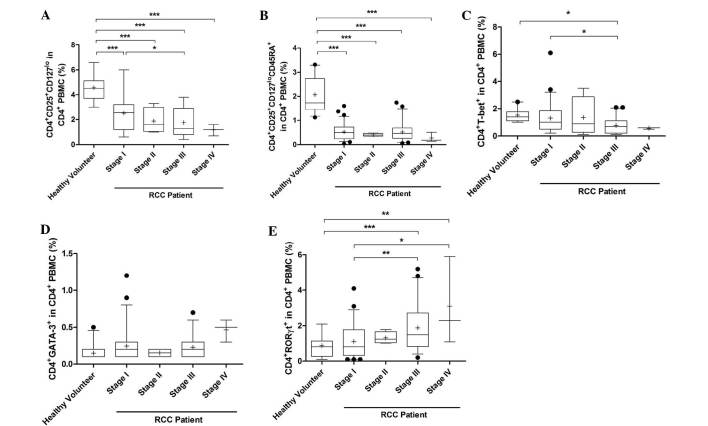
Proportion of Th1/Th2/Th17/Treg cells in different stages of RCC. (A) The percentage of activated Treg (CD4+ CD25+ CD127lo) cells was significantly decreased in stages I-IV (tumor-node-metastasis staging) of RCC patients compared with the healthy volunteers. (B) Percentage of activated Treg cells in stage III was decreased compared with that in stage I. The percentage of naïve Treg (CD4+ CD25+ CD127lo CD45A+) cells in stages I-IV of RCC patients was also decreased. (C) Percentage of Th1 (CD4+ T-bet+) cells in stage III was decreased significantly compared with in stage I and in the healthy volunteers. (D) Percentage of Th2 (CD4+ GATA-3+) cells was partially increased in stages I-IV compared with the healthy volunteers, although not significantly. (E) Percentages of Th17 (CD4+ RORγt+) cells in stages III and IV were markedly increased compared with that in the healthy volunteers. In addition, the proportion of Th17 cells in stages III and IV were higher compared with that in stage I. Data are expressed as the mean ±standard error of the mean. RCC, renal cell carcinoma; PBMC, peripheral blood mononuclear cell; Th, T helper cell; Treg, T regulatory cell; RORγt, RAR-related orphan receptor γt; GATA3, GATA binding protein 3. *P<0.05; **P<0.01; ***P<0.001.